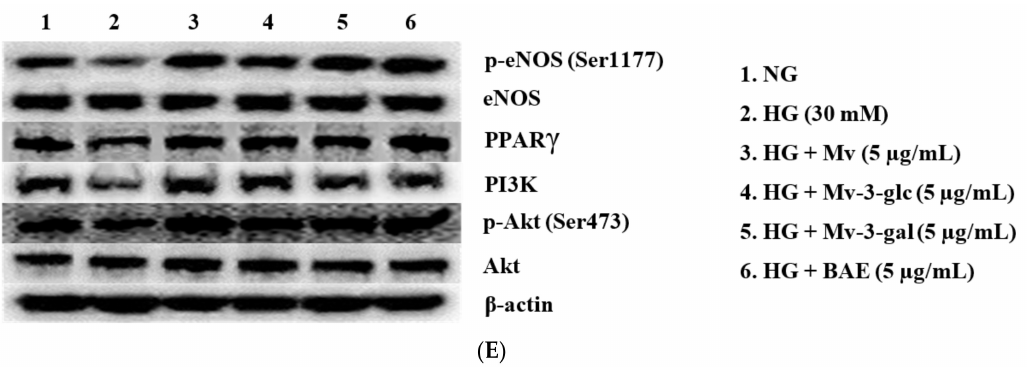
Figure6. Upregulatorye ff ectsofMv, Mv-3-glc, Mv-3-gal, andBAEon( A )p-eNOS / eNOS,( B )peroxisome proliferator-activated receptor- γ (PPAR γ ), ( C ) phosphoinositide 3-kinase (PI3K), and ( D ) p-Akt / Akt levels in HUVECs exposed to high glucose for 24 h. ( E ) Representative western blot bands are shown. Bars represent mean values ± SD ( n = 3). *, **, and *** indicate p < 0.05, p < 0.01, and p < 0.001, respectively, compared with the control NG; ## and ### indicate p < 0.01 and p < 0.001, respectively, compared with the HG